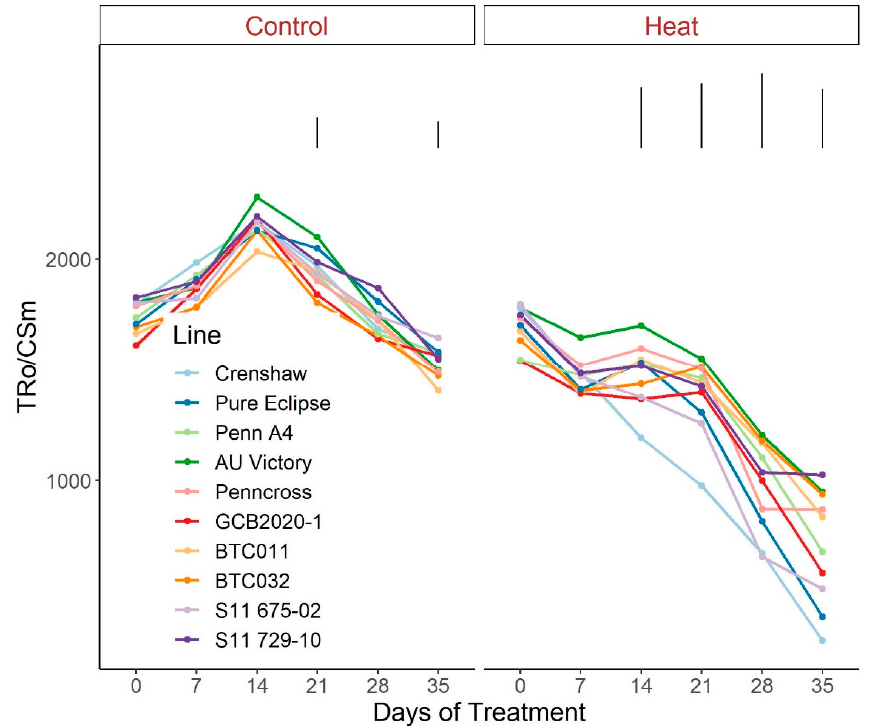
Figure 8. Change in Tro/CSm for creeping bentgrass lines over time under control (20/15 °C day/night) and heat stress (38/33 °C day/night) conditions. Bars represent LSD values at p = 0.05 on days when significant differences among lines were found.